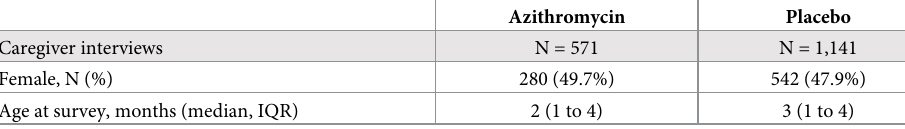
Table 1. Characteristics by study arm.